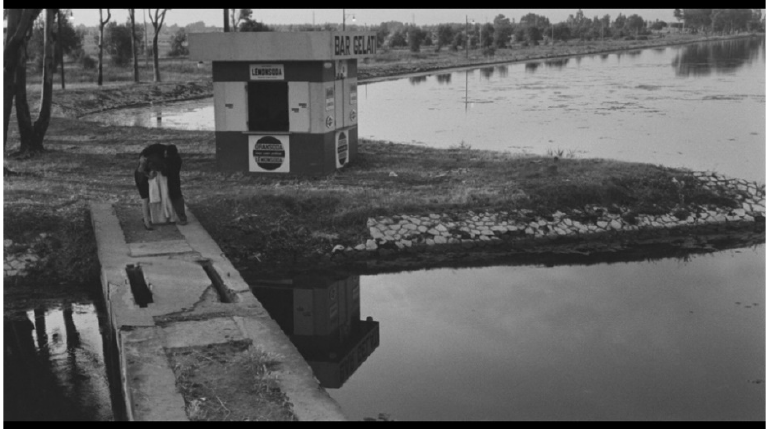
Figure 1 Screenshot from Rocco and His Brothers. (Goffredo Lombardo)